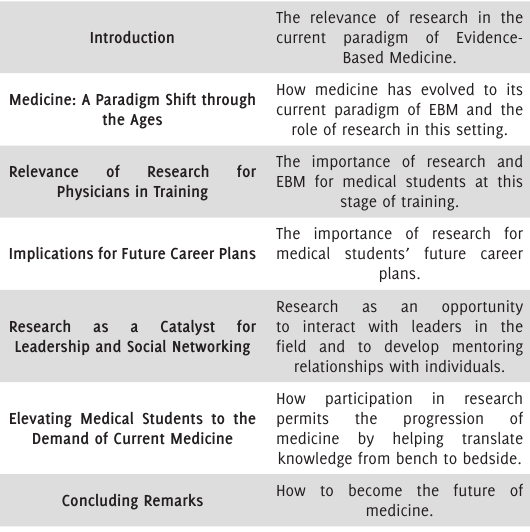
Table 1. Framework of topics that will be covered in this